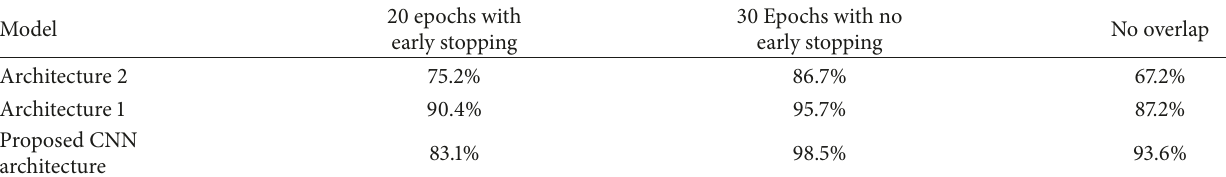
Table 28: Prediction accuracies for CWR.